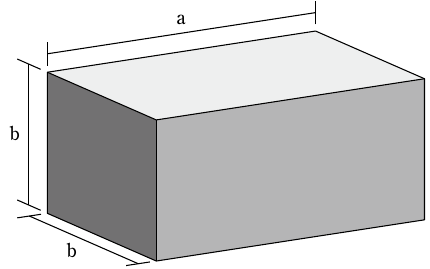
Fig. 3 . Shape Descriptors for a Square-Ended House Brick